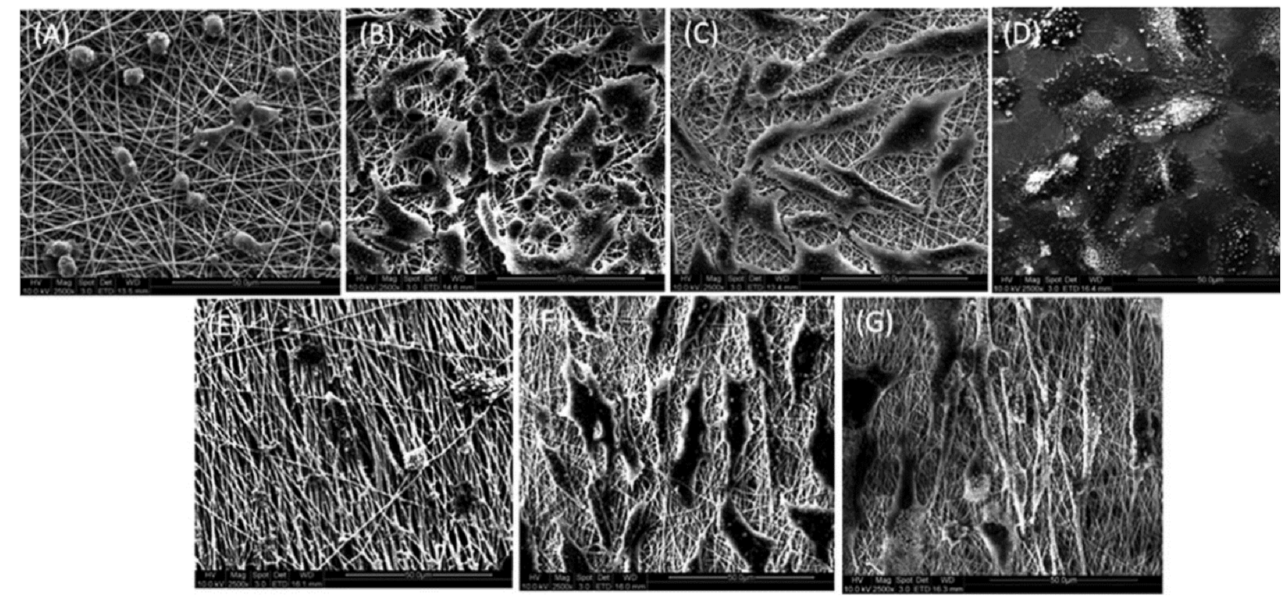
Figure 12. SEM images representing the interaction and orientation of cells on random ( A ) PHBV, ( B ) PHBV/Col75:25, ( C ) PHBV/Col50:50, ( D ) TCP, and aligned ( E ) PHBV, ( F ) PHBV/Col75:25, and ( G ) PHBV/Col50:50 nanofibers. Reproduced from [14] with permission from Wiley.